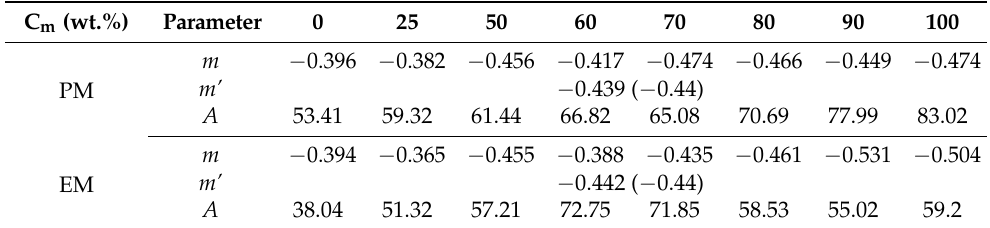
Table 2. Fitting parameters ( m , m’ and A ) of the Wöhler curves for powder mixing (PM) and extrusion mixing